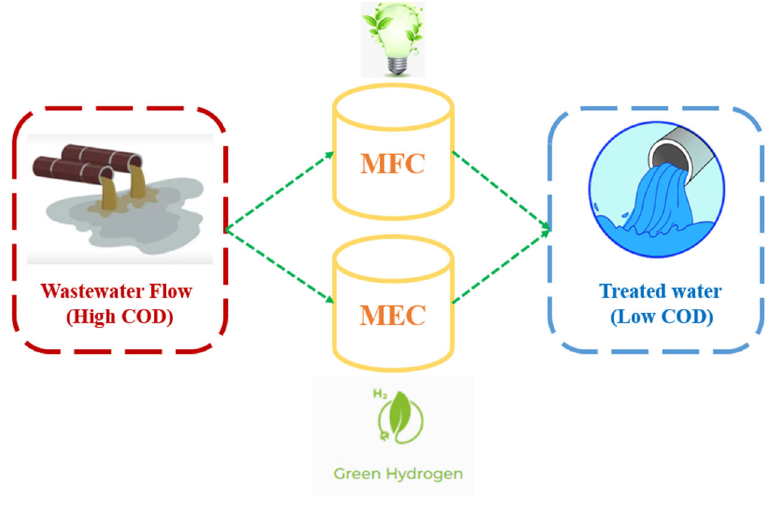
Figure 1. A general overview of MFC and MEC.